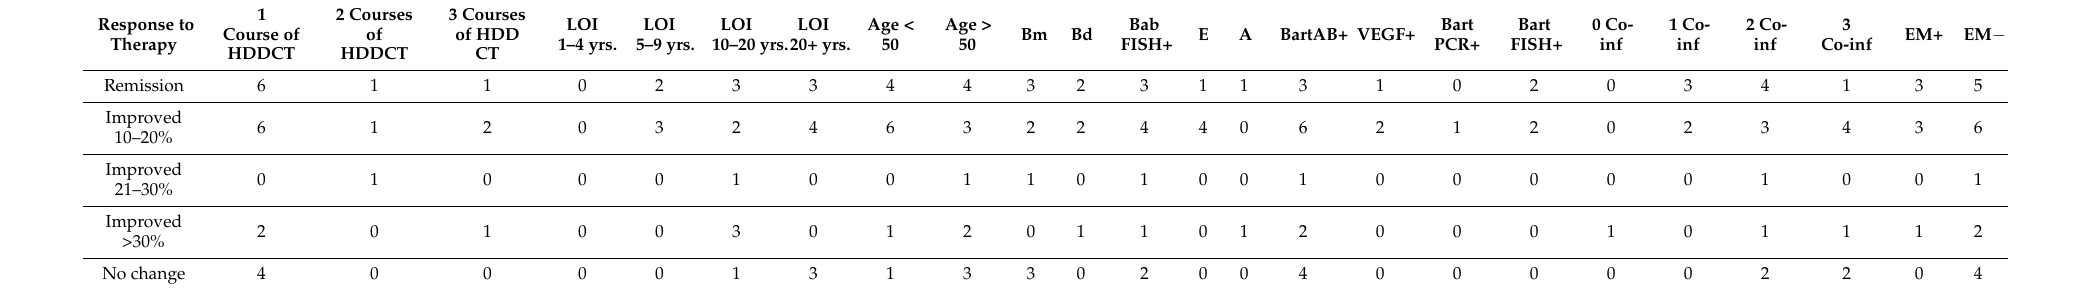
Table 2. Co-infection status and treatment response in 25 patients on